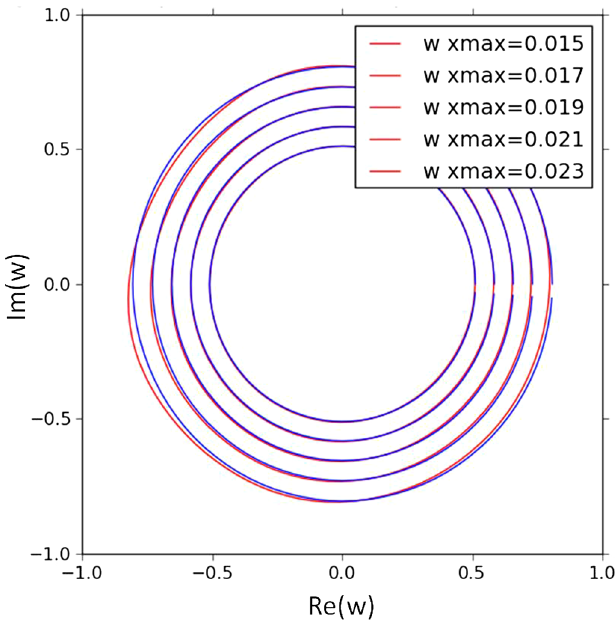
at seventh order in w x j